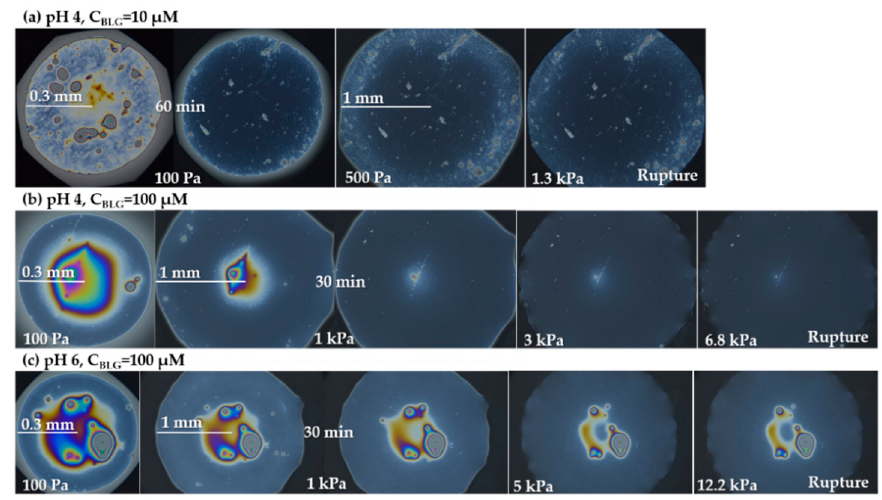
Figure 3. ( a – c ) Evolution of BLG black foam films at different pH and C BLG (C buff = 10 mM) formed slowly by protocol ‘A’.